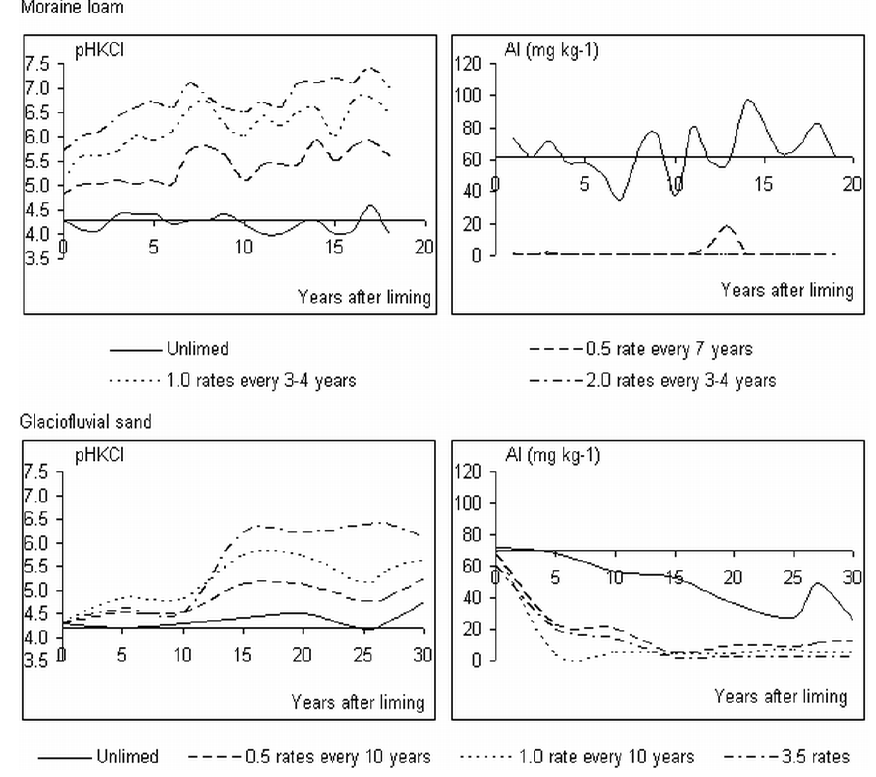
Fig. 5. The effect of periodic liming by different rates of dust limestone on the change of soil acidity